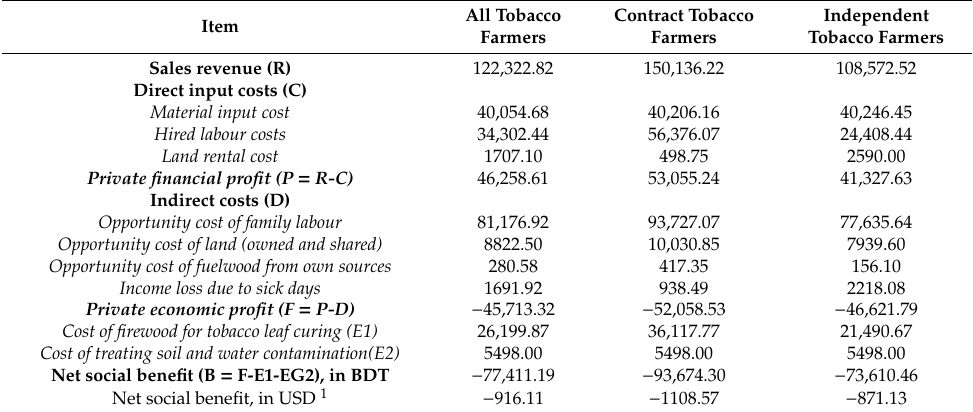
Table 13. Annual social net benefit from tobacco cultivation per acre of land use.